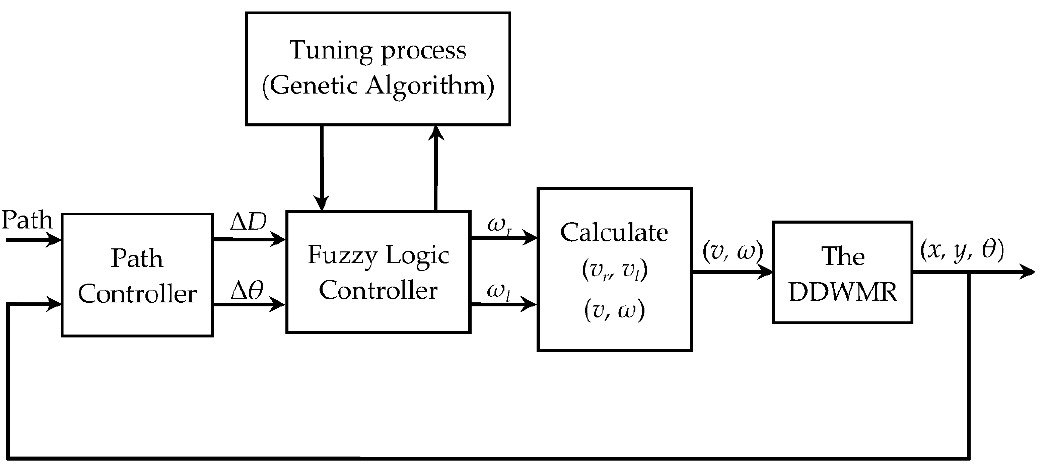
Figure 10. The optimization process used for optimization of the fuzzy logic controller. The FLC is created according to the chromosome, which represents all parameters of the MFs, and consequently, its behavior is tested by a simulation process. Results of such simulation are transformed into fitness function value. Such a process of mapping from the proposed solution to the fitness function result allows the use of